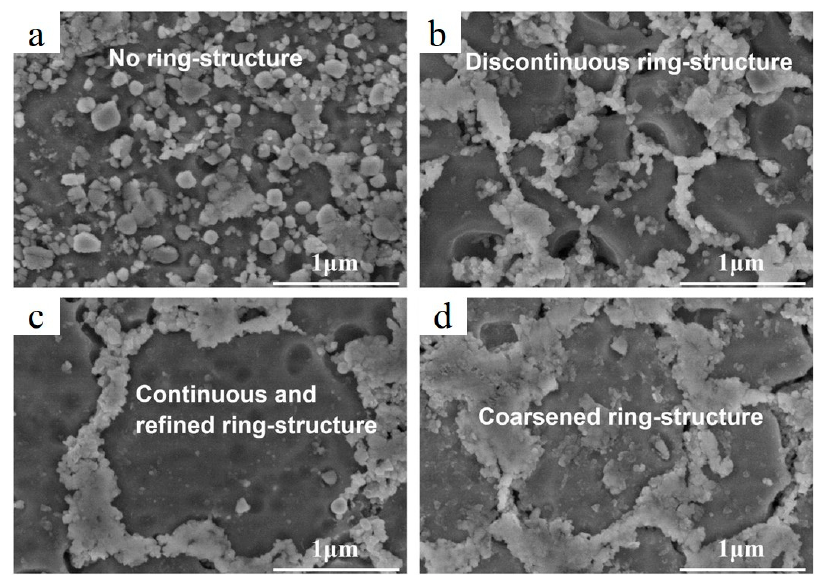
Figure 8. SEM images demonstrating the dispersion states of nano-TiC particles in LPBFed AlSi10Mg/3 wt.%TiC composites at E v = 160 J/mm 3 ( a ), E v = 200 J/mm 3 ( b ), E v = 240 J/mm 3 ( c ) and E v = 280 J/mm 3 ( d ) (reproduced with permission from [71]). The formation of ring-structured TiC was reported in Ref. [22] as well. At 5 and 7.5 wt.% TiC addition, at elevated Marangoni force and a lower viscous drag force, the ceramic particulates are captured in the circular melt motion (Figure 9b,c) and generate distinct circular structures in solidified build (Figure 9e–g). The circular-structured TiC agglomerate formation was not found in Ref. [70] when 5 wt.% TiC was used, which can probably be justified by the application of different process parameters.